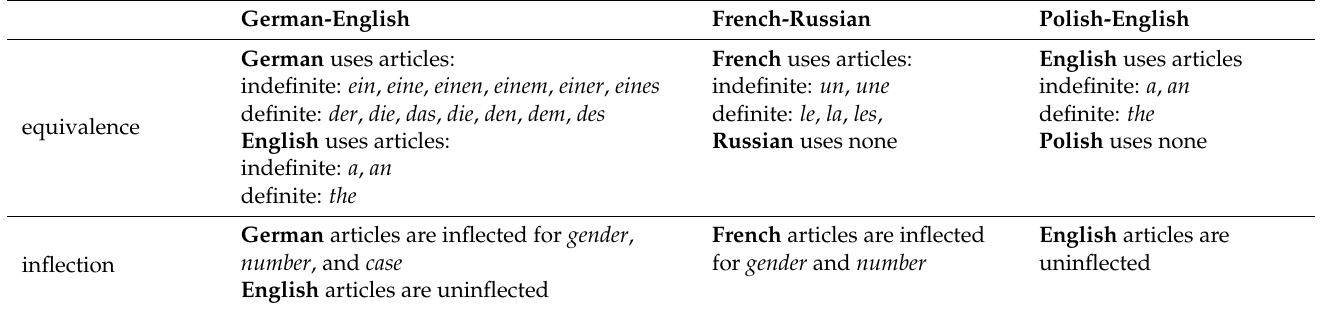
Table 1. Language pairs discussed in this